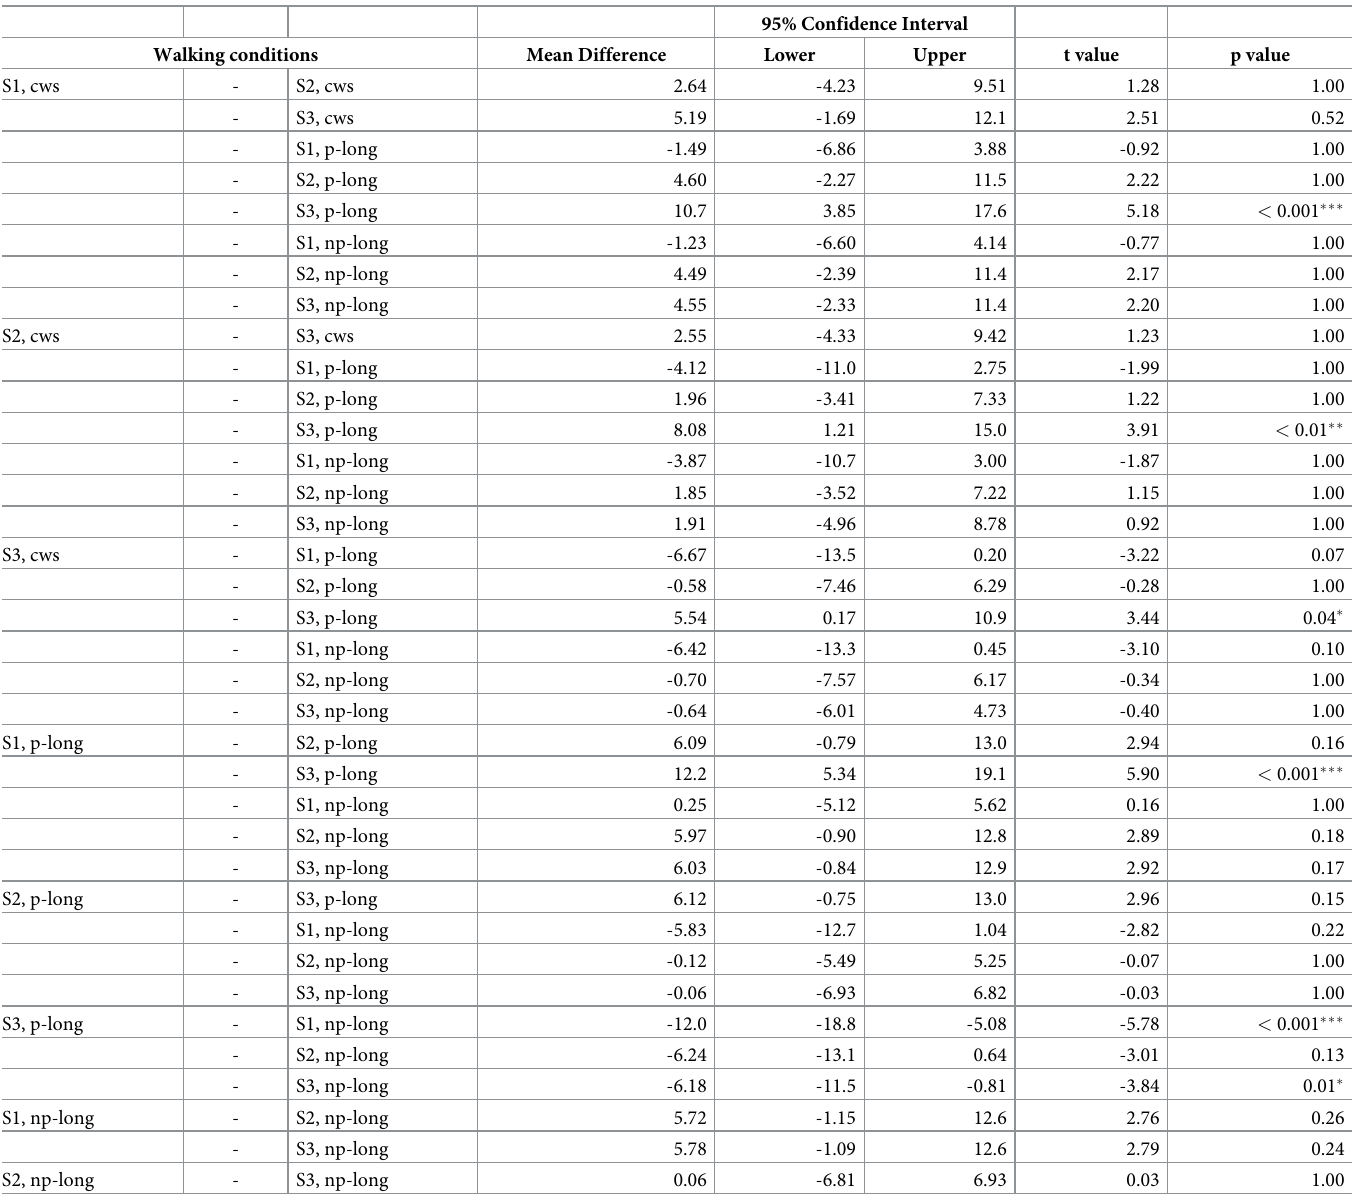
Table 3. Comparison of VAF1 across subtypes and walking